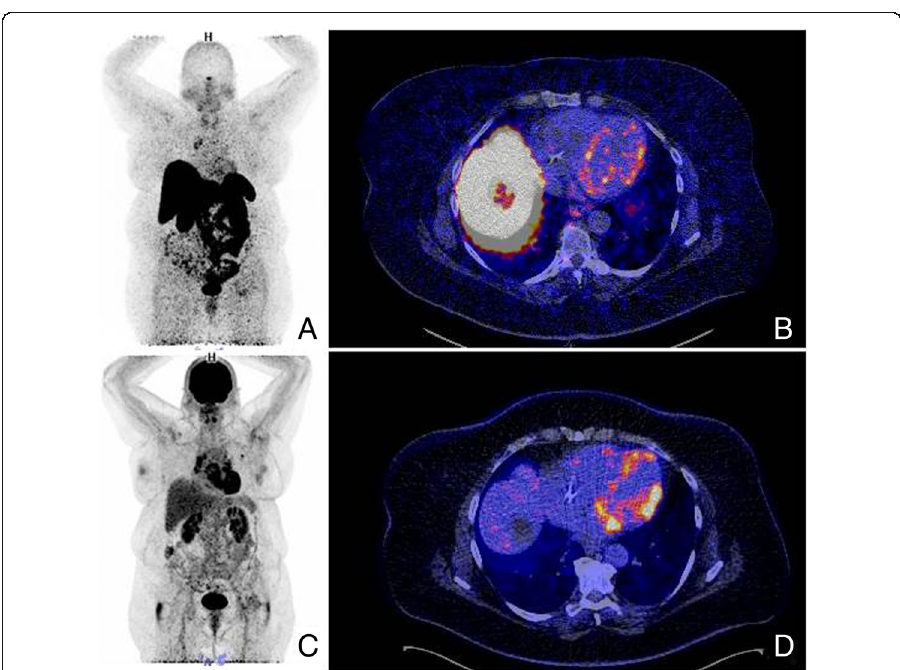
Fig. 1 68 Ga-Dotatoc whole body PET ( a ) in a 56-year old woman with chronic (cardiac) sarcoidosis. Increased uptake is visible in the lymph nodes located at the right-sideof the mediastinum and in lung hilar tissue. 68 Ga-Dotatoc PET/CT uptake ( b ) is visible in the left ventricle of the heart (lateral, basal, septal) and the anterior part of the right ventricle. The same distribution pattern is visible on FDG whole body ( c ) and cardiac PET ( d ), but is more intense. Apparently FDG PET was more helpful than 68 Ga-Dotatoc in the chronic phase of sarcoidosis in this